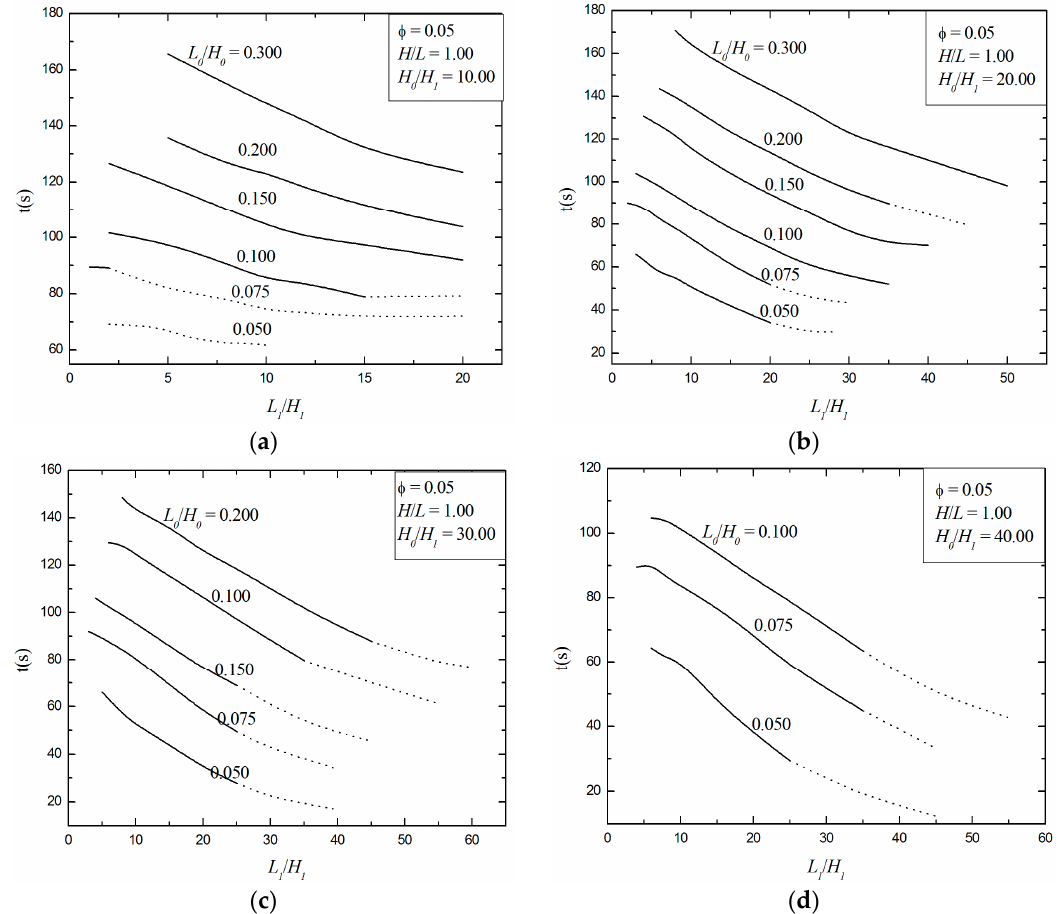
Figure 9. Effect of ratio L 1 /H 1 over resin infusion filling time for several values of ratio L 0 / H 0 and fixed values of H 0 / H 1 : ( a ) H 0 / H 1 = 10.0, ( b ) H 0 / H 1 = 20.0, ( c ) H 0 / H 1 = 30.0, ( d ) H 0 / H 1 = 40.0.